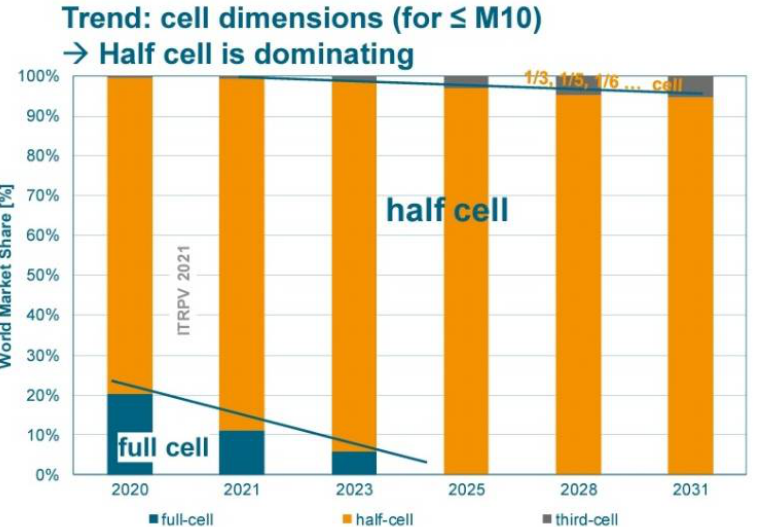
Figure 16. Market share of PV modules with full-, half- and third-cell layouts with wafer sizes below M10 [47].